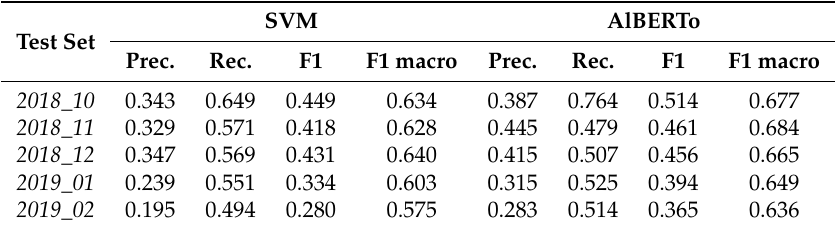
Table 6. Numerical results of the evaluation of the model trained on Sliding Window and Haspeede+ dataset. SVM AlBERTo Test Set Prec. Rec. F1 F1